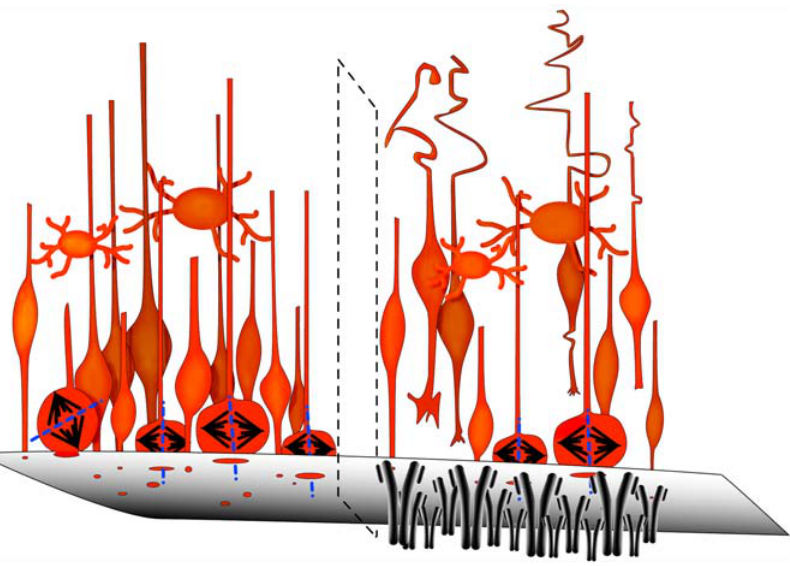
Figure 8. Model depicting the role of b 1 integrin in the VZ. Schematic (left) showing the normal VZ with NSC attached at the ventricular surface undergoing mitosis in a variety of orientations. After b 1 integrin blocking antibody injection (right), NSC detach from the ventricular surface and horizontal cell divisions are no longer present at the ventricular surface.